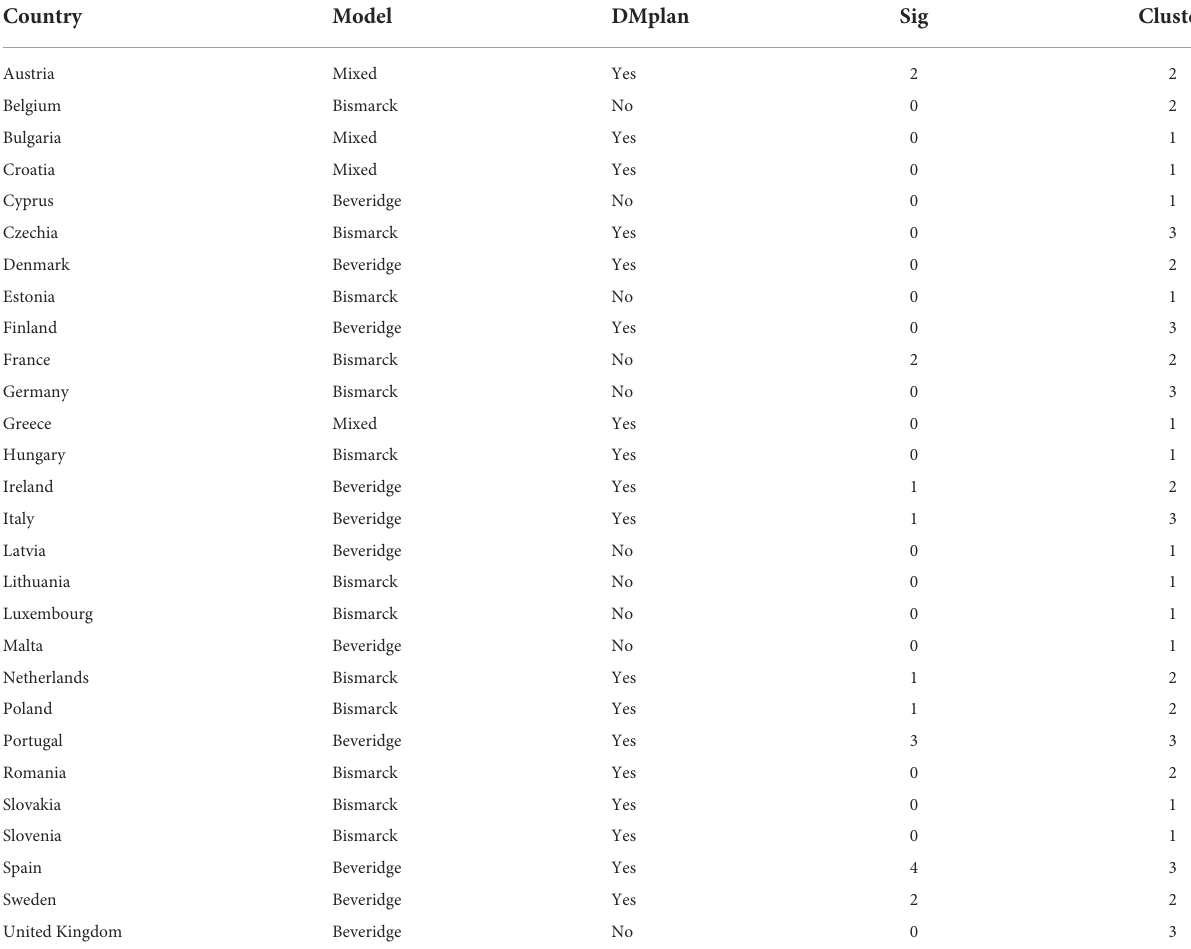
TABLE 2 Changes in citizens’ search behavior, clusters, and healthcare systems. Country